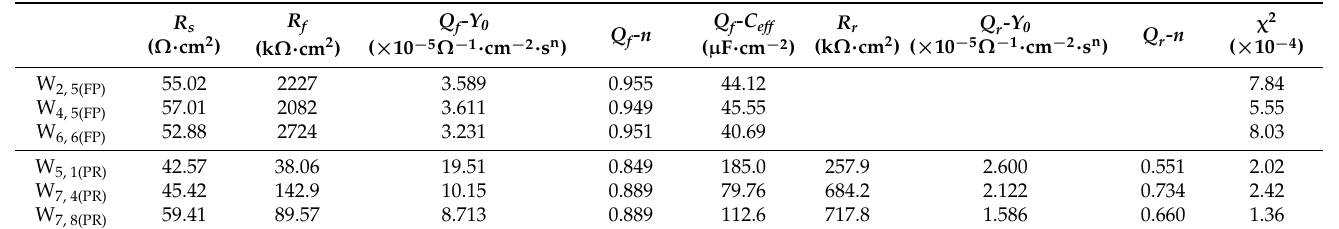
Table 1. The fitted parameters of the EIS measurement results at different surface